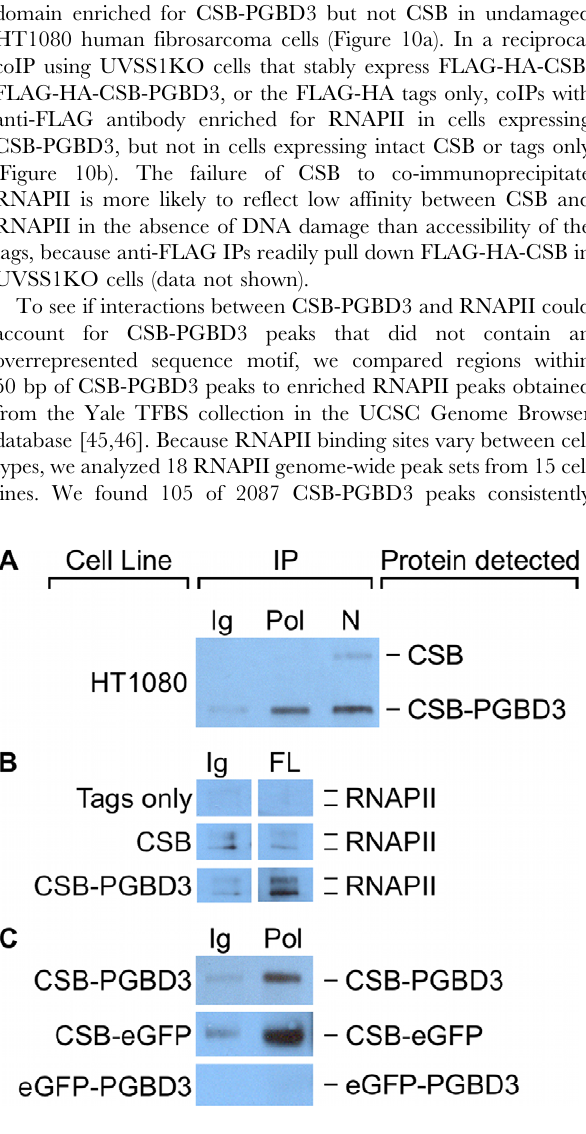
Figure 10. CSB-PGBD3 and CSB-eGFP co-immunoprecipitate with RNA polymerase II (RNAPII). (A) HT1080 whole cell lysates were immunoprecipitated using anti-RNAPII CTD antibodies, N-terminal CSB antibodies, or nonspecific antibodies. CSB and CSB-PGBD3 were detected by western blotting with antibodies against the N-terminus of CSB. (B) UVSS1KO cells expressing FLAG-HA tags only, FLAG-HA-tagged CSB, or FLAG-HA-tagged CSB-PGBD3 were immunoprecipitated using antibodies for FLAG tags or a nonspecific antibody control. RNAPII was detected by western blotting with antibodies against the CTD of RNAPII. (C) UVSS1KO cells expressing FLAG-HA-tagged CSB-PGBD3, CSB- eGFP, or eGFP-PGBD3 were immunoprecipitated with antibodies against the CTD of RNAPII or a nonspecific antibody control. CSB- PGBD3, CSB-eGFP, and eGFP-PGBD3 were detected by western blotting with anti-FLAG antibodies. Ig, anti-mouse IgG nonspecific control; Pol, anti-RNAPII CTD; N, anti-CSB N-terminus; FL, anti-FLAG.